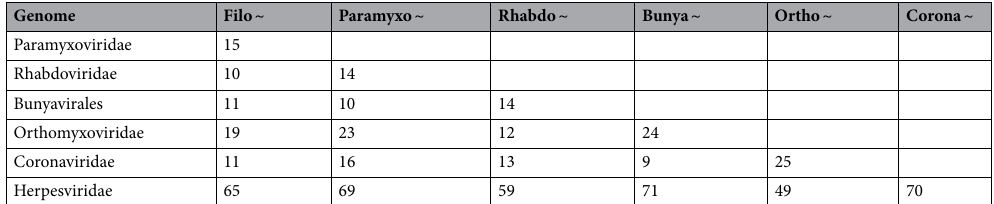
Table 1. Comparison of viral heatmaps. The number of differences in third nucleotide bias (color, not magnitude) between heatmaps for the genomes of various viral families are shown. Virus family names in the top row are truncated with ~ replacing